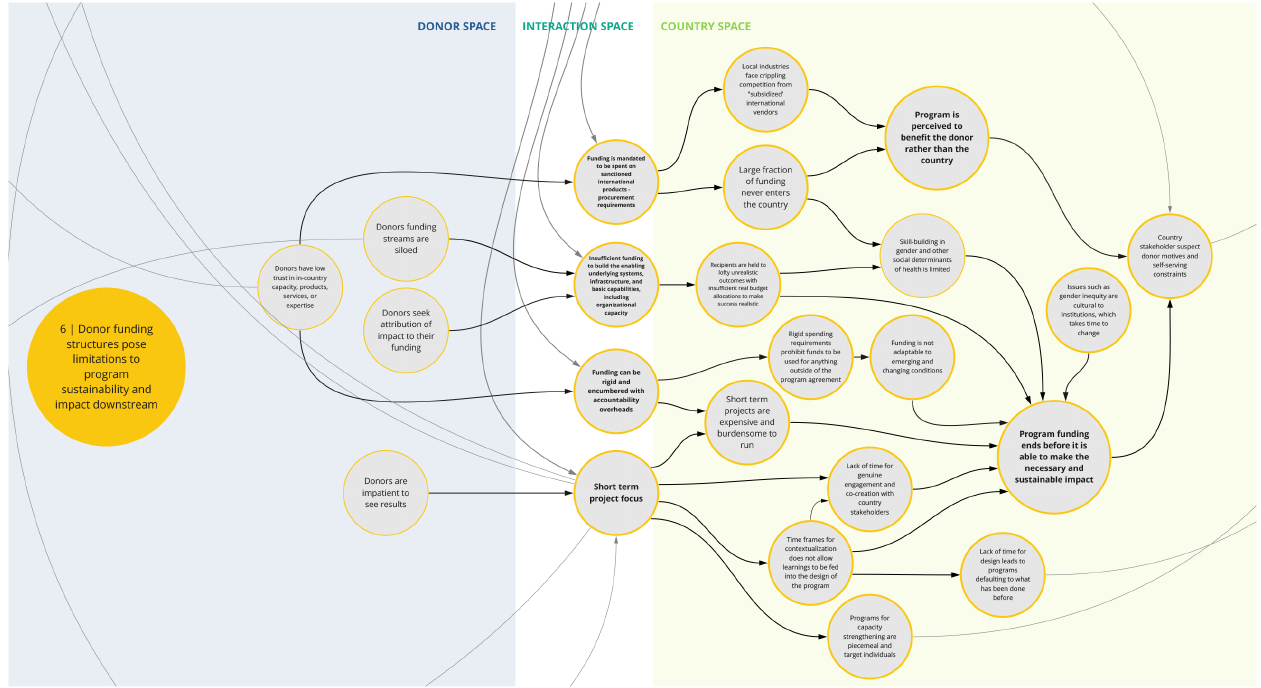
planning.Figure 7. Syndrome 6: Donor funding structures pose limitations to program sustainability and impact